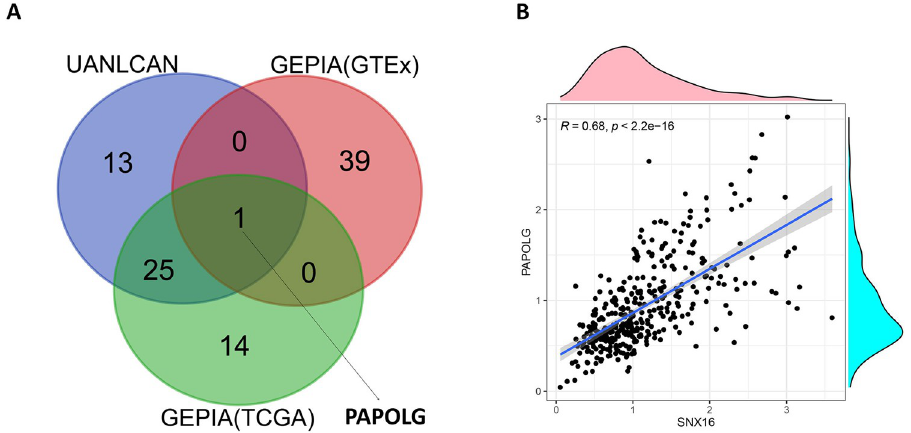
Fig 3. Screening of genes associated with SNX16. (A) Venn diagram showing SNX16-related genes shared by GEPIA (GTEx) database, TCGA database data, and UALCAN. (B) correlation analysis of SNX16 with PAPOLG expression.